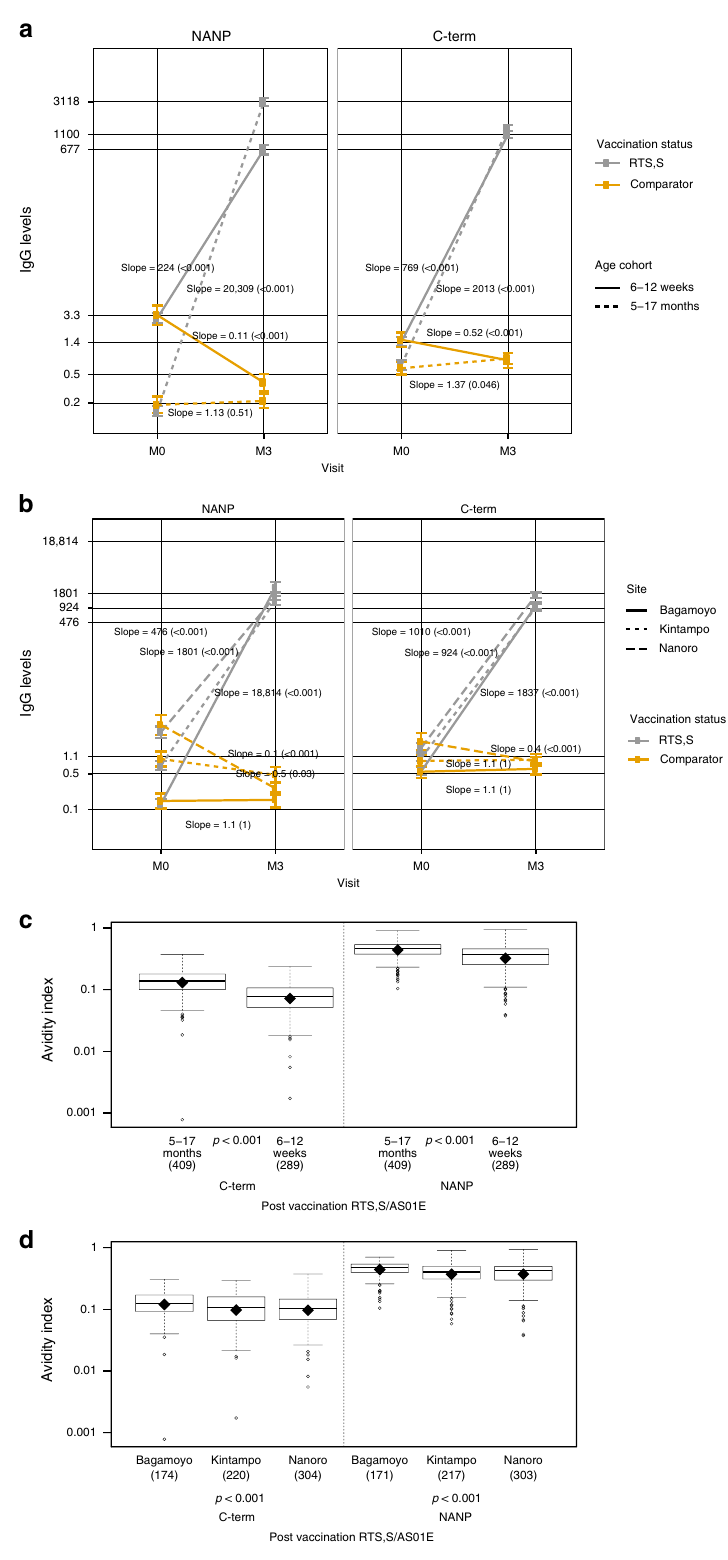
Fig. 2 Effect of age cohort and site on RTS,S/AS01E immunogenicity. Comparison of the impact of RTS,S/AS01E vaccination on anti-CSP responses across age cohorts ( a IgG; c AI) and sites ( b IgG; d AI). a Estimates of changes over time of infants (aged 6 – 12 weeks at vaccination) and children (aged 5 – 17 weeks at vaccination) and statistical signi fi cance of those were estimated through multivariate mixed models. Trajectories of NANP of infants and children were signi fi cantly different within vaccination group (all p values< 0.001). b Estimates of changes over time in each study site. Trajectories were statistically signi fi cantly different across sites ( p adjusted for multiple testing for all pairwise comparisons < 0.001). Post-vaccination AI is compared across age cohorts ( c ) and sites ( d ) through t -tests and ANOVA, respectively. Boxplots illustrate the medians and the 25th and 75th quartiles, diamonds show the geometric mean, whiskers display the 1.5 interquartile ranges, and dots the outliers. M0: pre-vaccination, M3: